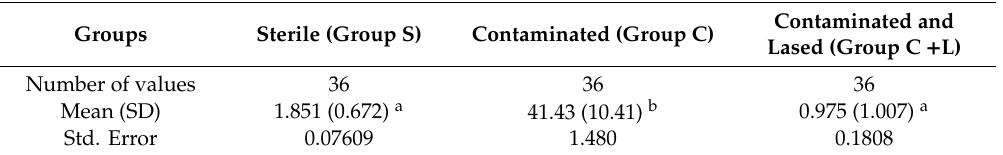
Table 5. Mean values (standard deviation (SD)) of Carbon Mass (%) analysis according to groups. Lowercase superscript letters indicate statistically significant differences (Newman–Keuls; p < 0.0001) between groups.